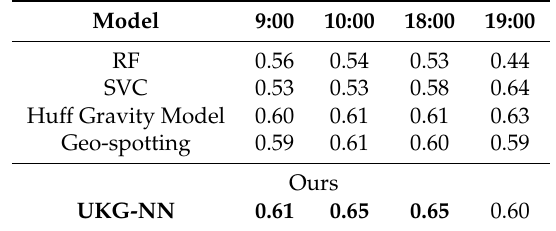
Table 3. Results of traffic accident inference.